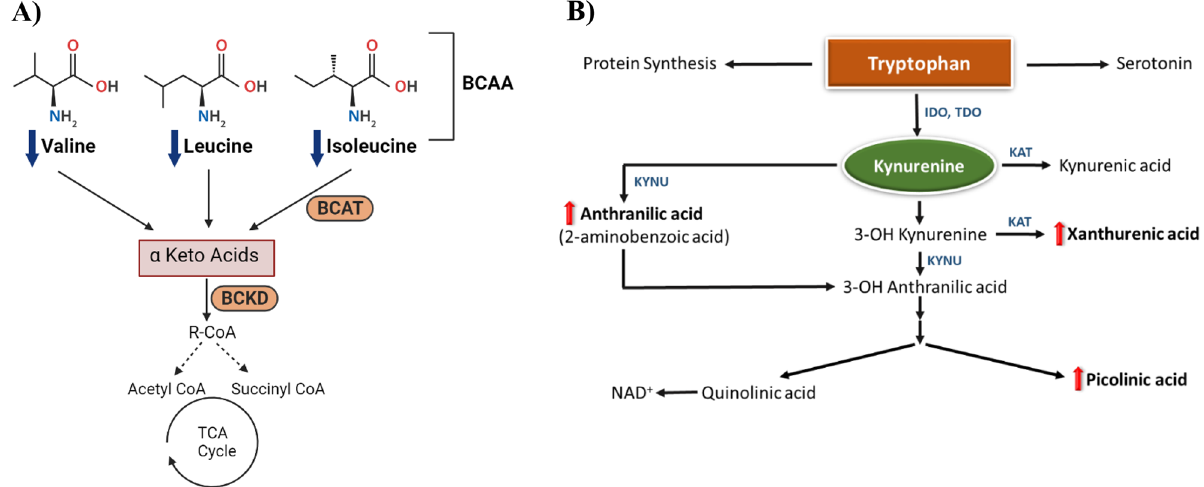
Figure 6. ( A ) Main steps of branched chain amino acids (BCAA) catabolism. BCAT and BCKD stand for branched-chain amino acid transaminase and branched-chain keto acid dehydrogenase, respectively. ( B ) The kynurenine pathway of tryptophan metabolism. IDO indoleamine 2,3-dioxygenase, TDO tryptophan 2,3-dioxygenase, KAT kynurenine aminotransaminase, KMO kynurenine 3-monooxygenase, KYNU kynureninase, NAD + Nicotinamide adenine dinucleotide. Red and blue arrows indicate increase and decrease in the level of the metabolite in ESRD compared to CKD,